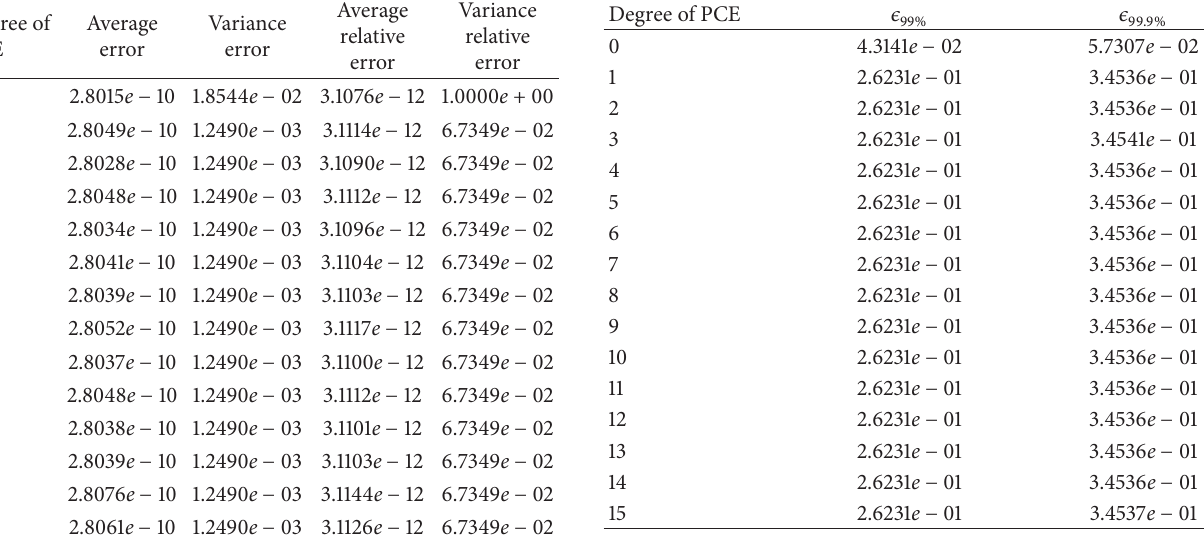
Table 7: Absolute errors of the two quantiles PCE approximation of Vasicek interest rate model at time 𝑇 = 1 . The parameters are set as 𝛼 = 0.1 , 𝛽 = 0.2 , 𝜎 = 0.15 , and 𝑅 0 = 110